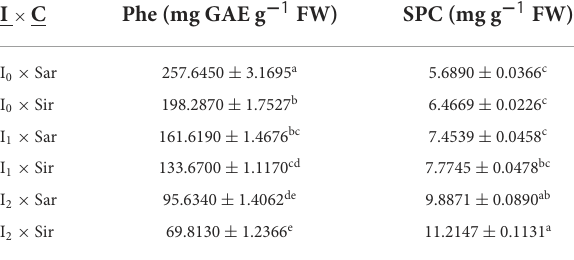
TABLE 7 Mean comparisons of the dual interaction of cultivar and irrigation levels on phenol and soluble proteins content traits 2 years of experiment (2017–2018 and 2018–2019).